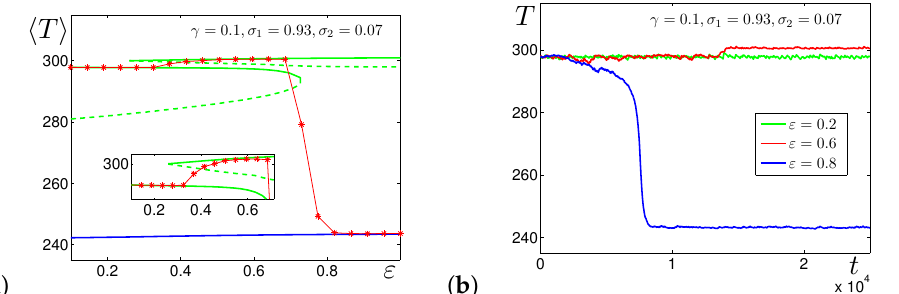
Figure 12. Stochastic transformations in system (2), (3) with γ = 0.1, σ 1 = 0.93, σ 2 = 0.07: ( a ) mean values of T -coordinates (asterisks) and theoretical curves (green), ( b ) time